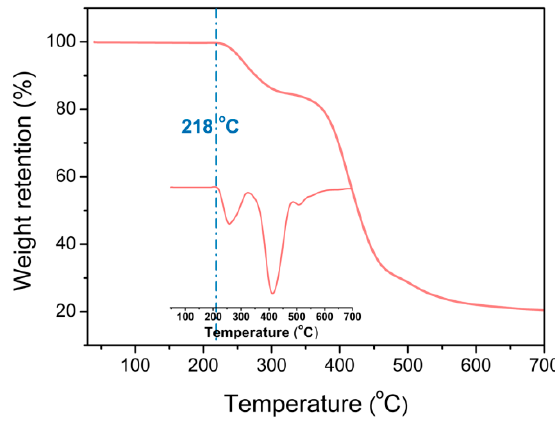
Figure 8. Thermogravimetic analysis (TGA) and differential thermal gravity (DTG, illustration) curves of membrane C-HBM-1.78.